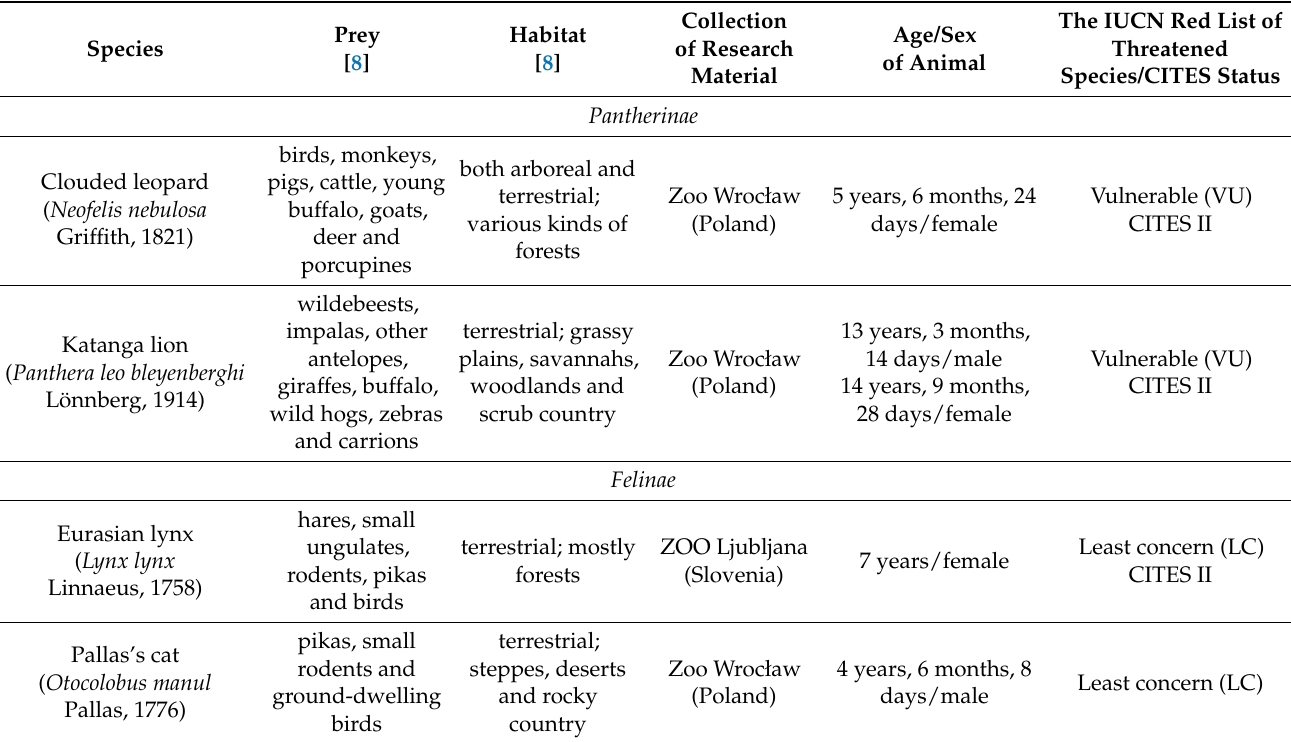
Table 1. Felids described in current